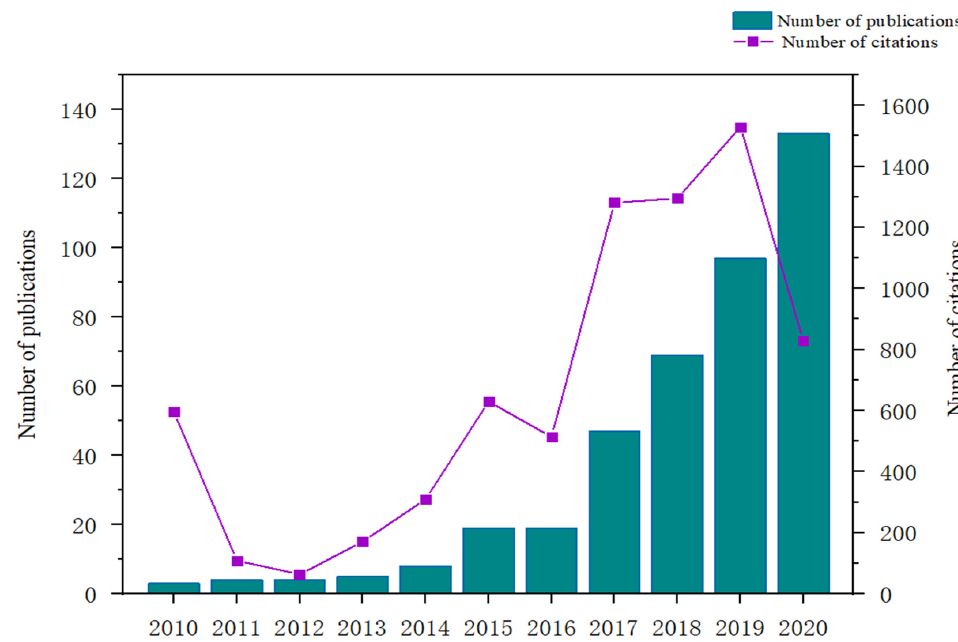
Figure 4. Number of publications and citations in China from 2010 to